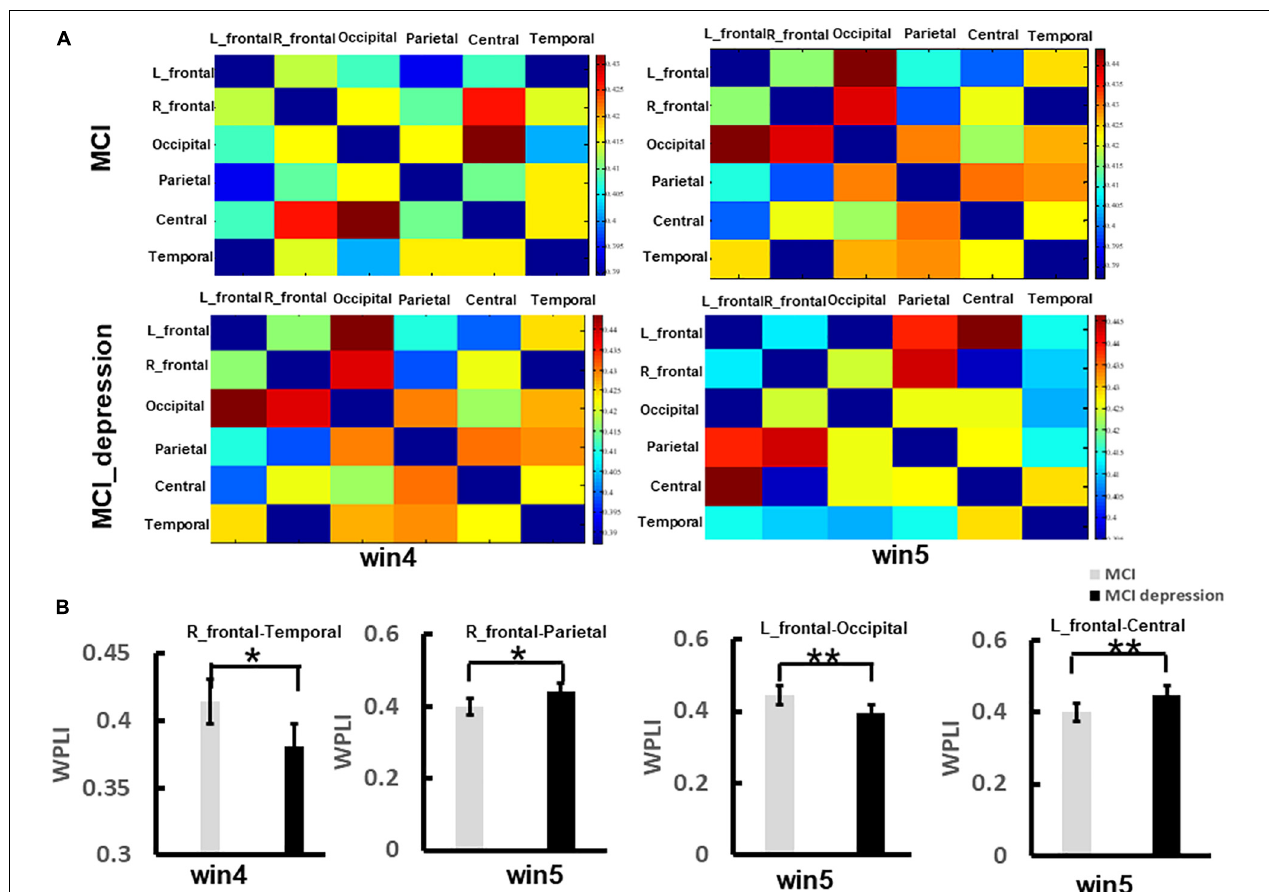
FIGURE 5 | The significant difference of functional connectivity matrix between two groups during the Emotion Regulation task. (A) Illustrates the matrix of functional connectivity between 6 brain areas (left-frontal lobe, right frontal lobe, parietal lobe, occipital lobe, temporal lobe, and central regions) of two group. (B) Illustrates the group difference of right frontal-temporal lobe, right frontal-parietal lobe, left frontal-occipital lobe, left frontal-centrals lobe. ∗ p < 0.05, ∗∗ p <